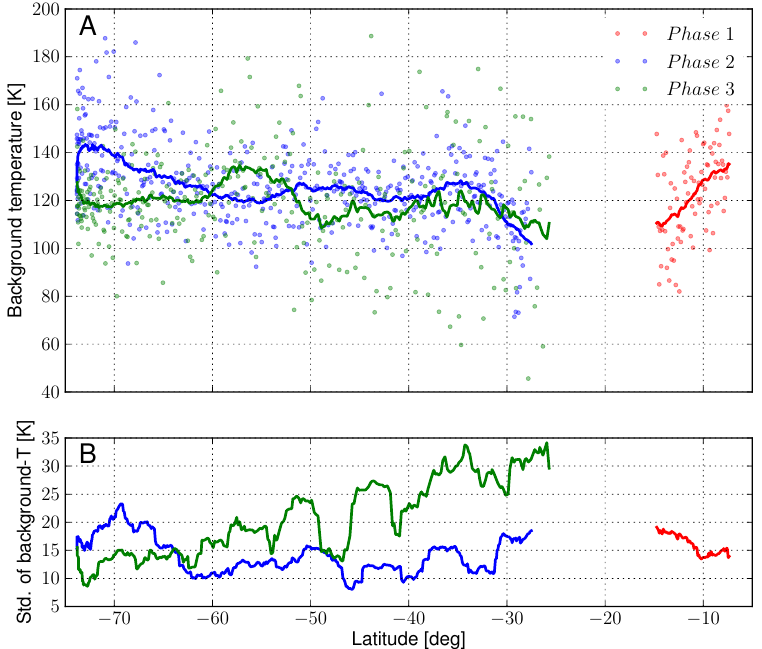
Figure 10. ( A ) The derived background temperature as the function of latitude. Dots represent individual passes, and the solid lines show the running average over passes within ( B ) RMS variations of the derived temperature with respect to the running average.